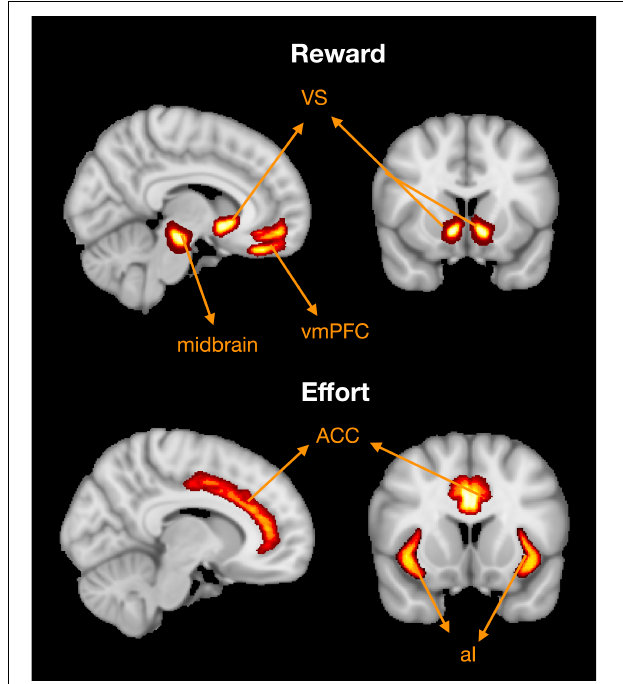
FIGURE 4 | Brain regions associated with reward and effort processing. Based on a meta-analysis of functional MRI studies (Pessiglione et al., 2018). Reward processing associated with activation in the ventromedial pre-frontal cortex (vmPFC), ventral striatum (VS), and ventral tegmental area within the midbrain. Effort processing clusters are principally found in the dorsal anterior cingulate cortex (ACC) and anterior insula (AI). Adapted from Figure 5 in Pessiglione et al.